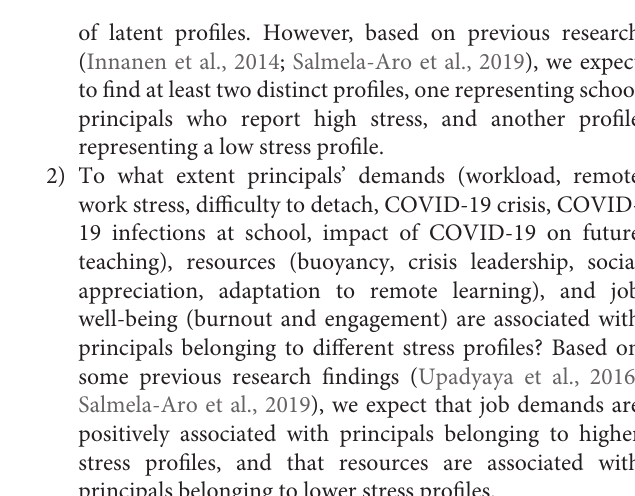
FIGURE 1 | Model of the associations between job demands, resources, occupational well-being and current